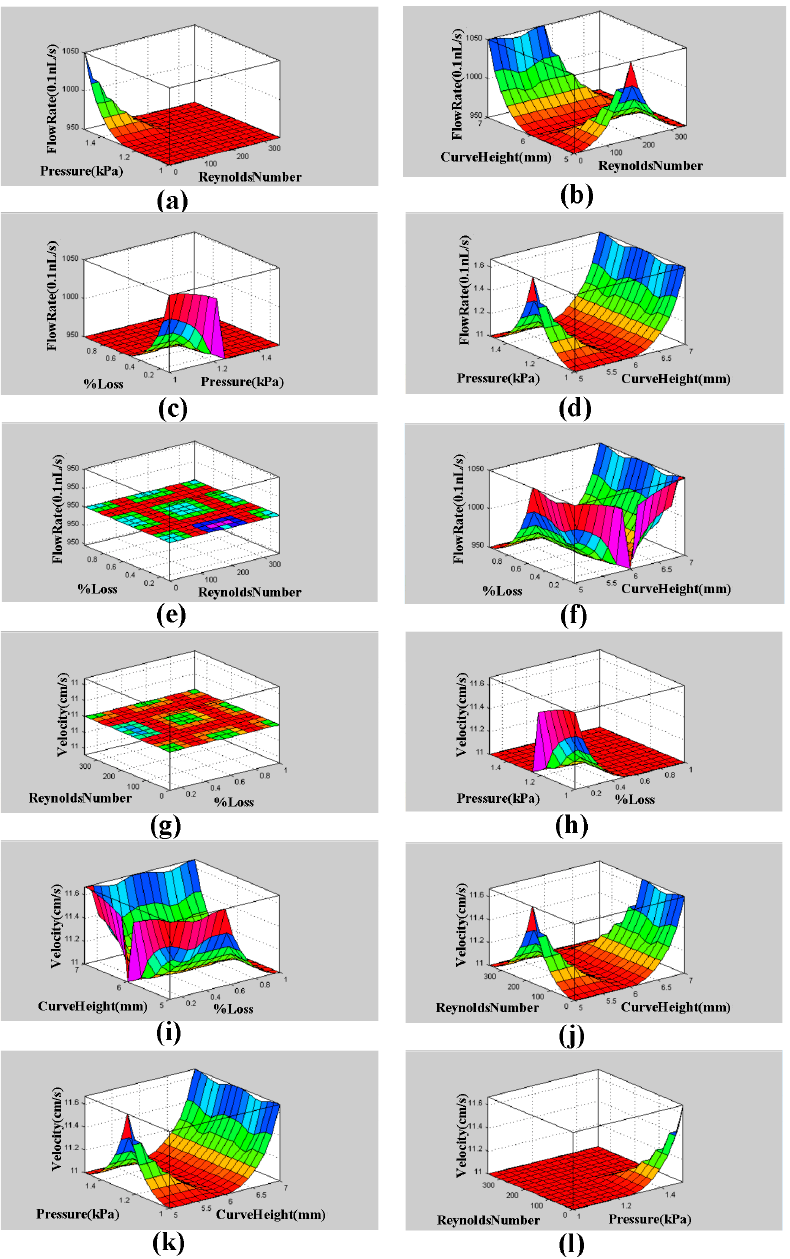
Figure 4. The graphs of surface viewer (3D): ( a ) Flow rate relies upon pressure and Reynolds number; ( b ) Flow rate relies upon Reynolds number and curve height; ( c ) Flow rate relies upon pressure and % loss; ( d ) Flow rate relies upon curve height and pressure; ( e ) Flow rate relies upon Reynolds number and % loss; ( f ) Flow rate relies upon curve height and % loss; ( g ) Velocity relies upon % loss and Reynolds number; ( h ) Velocity relies upon % loss and pressure; ( i ) Velocity relies upon % loss and curve height; ( j ) Velocity relies upon curve height and Reynolds number; ( k ) Velocity relies upon pressure and curve height; ( l ) Velocity relies upon Reynolds number and pressure. Mamdani’s value, MATLAB simulation results, difference, and error percentage are given in Table 2 below.